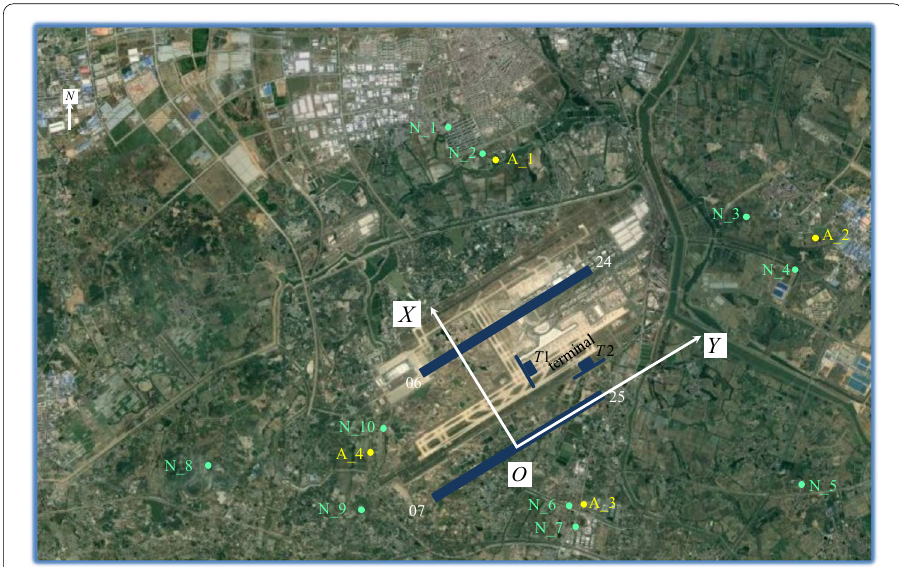
Fig. 5 Coordinate of concentration evaluation and evaluation range at NKG